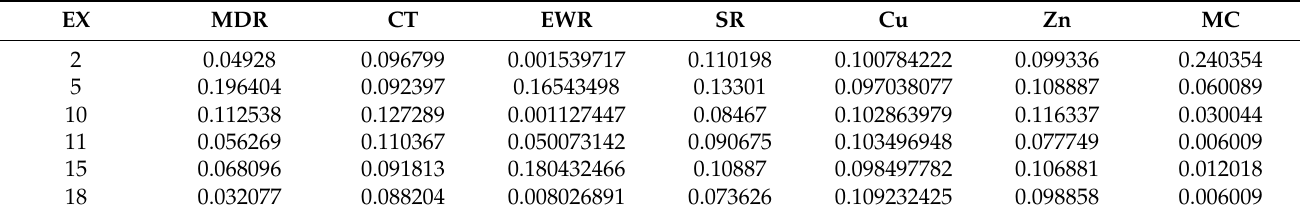
Table 9. Weighted normalized decision matrix.